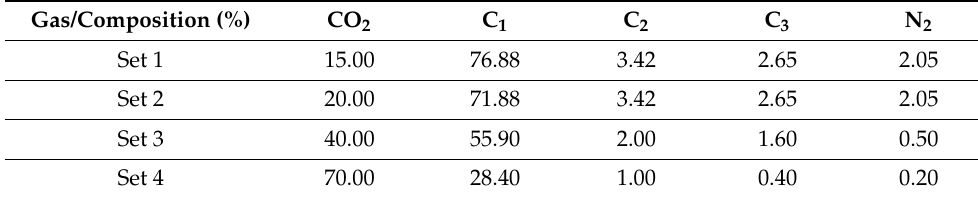
Table 1. Gas composition used in this